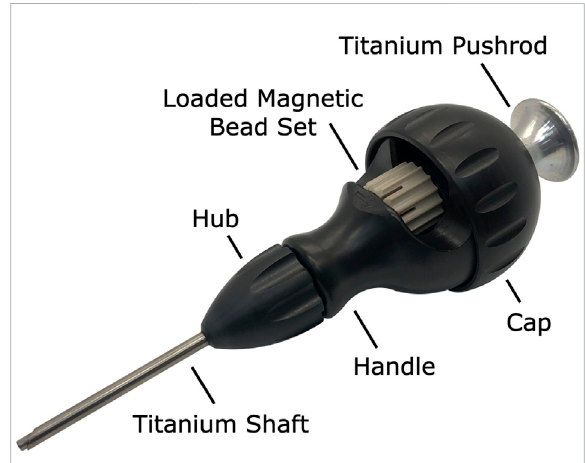
FIGURE 4 Custom halifax magnetic bead insertion device. A custom magneticbeadinsertiondeviceenablesthesurgeontoimplantthe magnetic beads directly into the muscle without directly handling the implants. The device reuses the design for tantalum